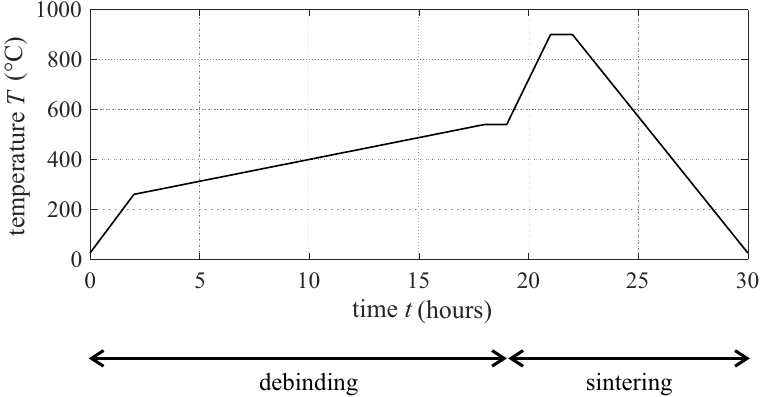
Figure 2. Temperature profile of the debinding and sintering process.